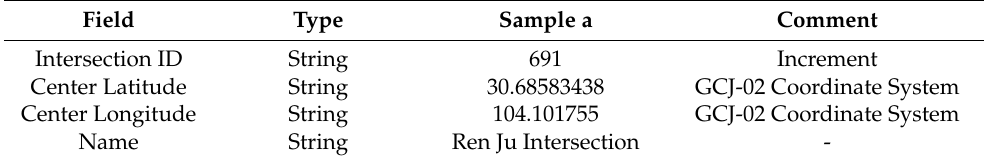
Table 2. Intersection location